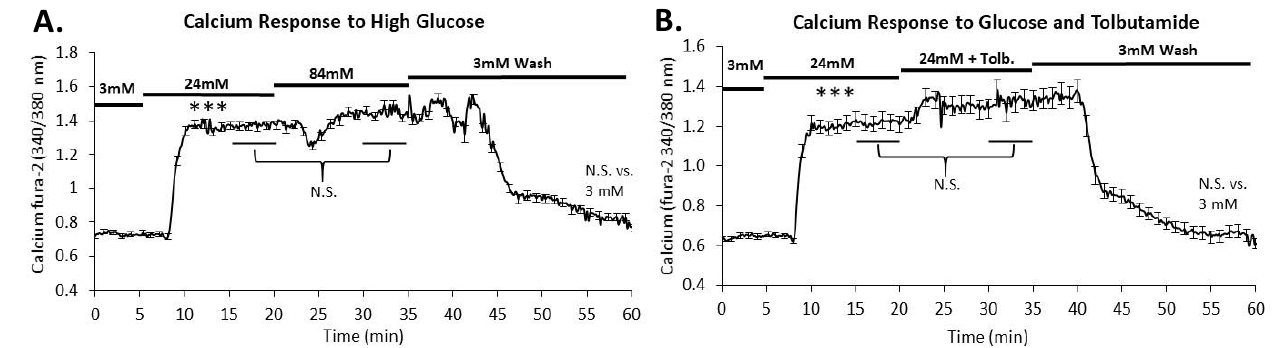
Figure 3. Effects of high glucose on intracellular calcium. ( A ) Intracellular calcium was measured in islets exposed to the increasing glucose conditions noted by the horizontal bars. Calcium levels increased sharply from 3 mM to 24 mM glucose but did not increase further when exposed to 84 mM glucose. Average calcium levels from 23 islets were calculated from the 15–20- and 30–35 min time points and showed no significant difference. ( B ) Intracellular calcium was measured in islets exposed to the increasing glucose conditions and tolbutamide noted by the horizontal bars. Calcium levels increased sharply from 3 mM to 24 mM but did not increase further when exposed to 24 mM glucose combined with 250 μM tolbut- amide. Average calcium levels from 23 islets were calculated from the 15–20 and 30–35 min time points and showed no significant difference. *** p < 0.001 difference between 3 and 24 mM glucose.